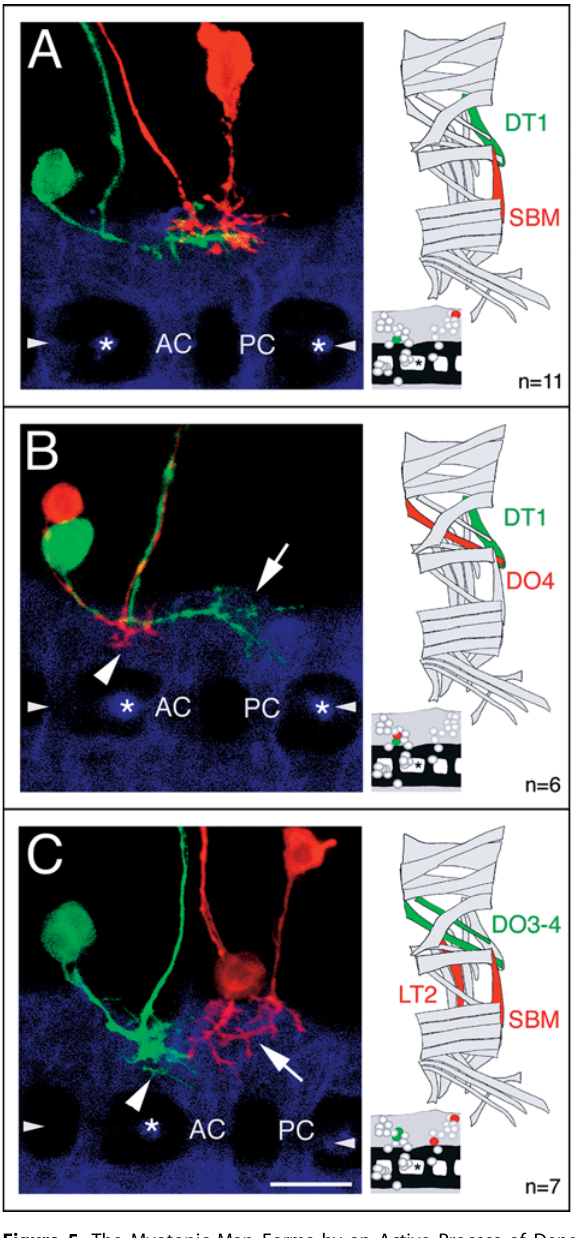
Figure 5. The Myotopic Map Forms by an Active Process of Dendritic Growth and Arborisation ISN motor neurons (indicated in muscle diagrams) were retrogradely labelled in 15-h-old wild-type embryos. The neuropile, visualised with anti-HRP, is shown in blue. (A) External transverse muscle DT1 is innervated by an ISN motor neuron (green) whose dendrites overlap with those of the SBM motor neuron (red). (B and C) Internal muscles DO3–DO5 are innervated by motor neurons derived from the same NB as the DT1 motor neuron, and all have common axonal trajectories. However, dendrites of the DO3– DO5 motor neurons (arrowheads) form anterior to those of the DT1 (arrow in [B]) and the SN motor neurons (arrow in [C]). Anterior is left and dorsal is up. Symbols and abbreviations: triangles, ventral midline; AC, anterior commissure; PC, posterior commissure; asterisks, dorsoventral channels (landmarks for the segment borders). Scale bar (not applicable to diagrams of CNS and muscle field): 10 l